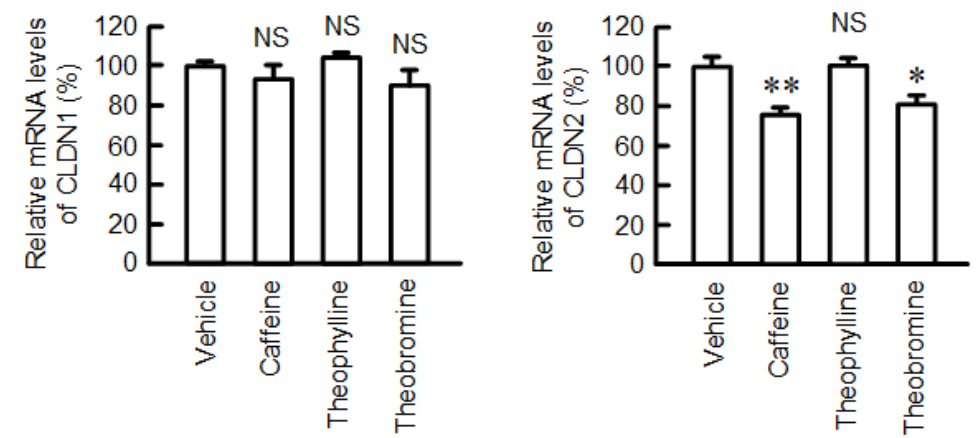
Figure 4. Effects of coffee ingredients on the mRNA levels of CLDNs. The mRNA levels of CLDN1 and CLDN2 were measured using real-time PCR and are represented as a percentage relative to vehicle. n = 3 – 4. ** p < 0.01, * p < 0.05, and NS p > 0.05 compared with vehicle.